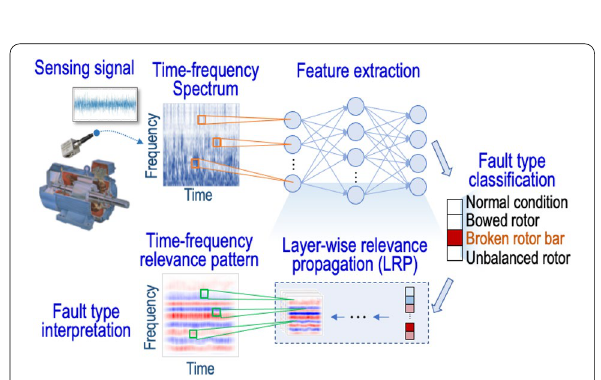
Figure 20 Interpretable CNN using LRP for motor fault diagnosis, adapted from Ref. [117]